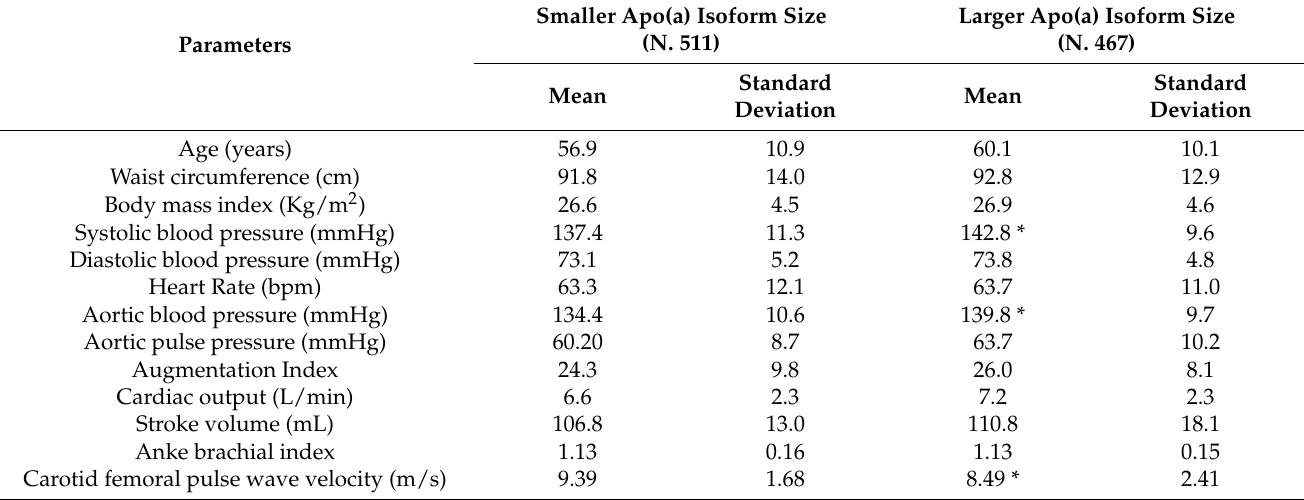
Table 2. Clinical and haemodynamic characteristics of the population sample, reported by apo(a) isoform